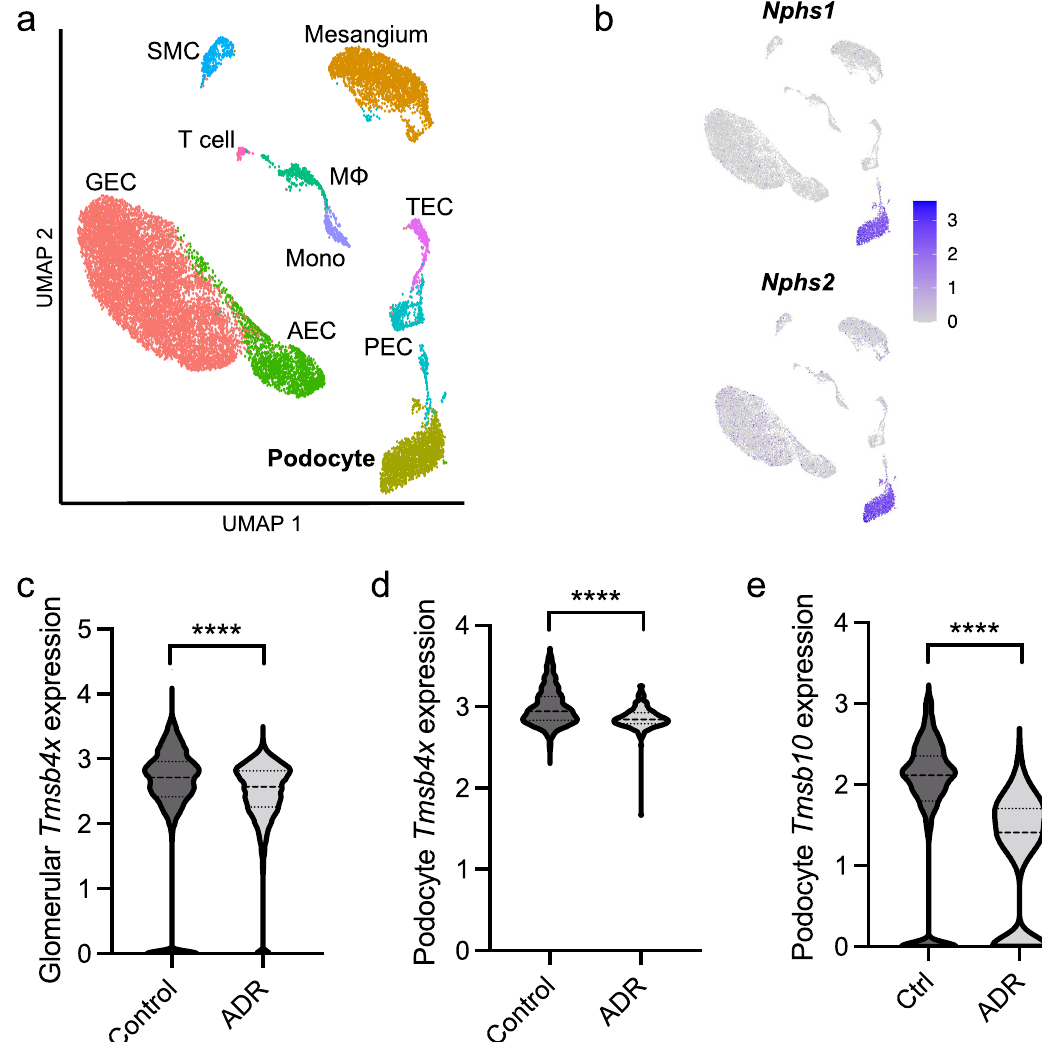
Figure 1. Podocyte-specific Tmsb4x and Tmsb10 expression is downregulated in murine Adriamycin nephropathy. (a) Uniform manifold approximation and projection (UMAP) from single-cell RNA sequencing data of 8412 glomerular cells from two wildtype (control) mice and 8296 glomerular cells from mice with Adriamycin nephropathy (ADR). After analysis and cell type assignment, ten transcriptionally distinct cell populations were discriminated including arterial endothelial cells (AEC), glomerular endothelial cells (GEC), macrophages (MΦ), mesangial cells, monocytes (Mono), parietal epithelial cells (PEC), podocytes, smooth muscle cells (SMC), T cells, tubular epithelial cells (TEC). The markers used for cell type identification and assignment, and the numbers of cell types per condition, are shown in Supplementary Fig. 1. (b) Feature plots showing expression of nephrin (Nphs1) and podocin ( Nphs2), canonical markers of podocytes, across the dataset. (c) Violin plot comparing the scaled expression of Tmsb4x of all glomerular cells (podocytes, GECs, mesangium) between ADR ( n = 5602 cells) and control ( n = 7190 cells). An average log fold decrease of 0.23 was detected in ADR compared to control (*: adjusted P value < 0.0001). (d) Violin plot comparing the scaled expression of Tmsb4x of podocytes between ADR ( n = 378 cells) and control ( n = 1486 cells). An average log fold decrease of 0.52 was detected in ADR compared to control (****: adjusted P value < 0.0001). (e) Violin plot comparing the scaled expression of Tmsb10 of podocytes between ADR and control. An average log fold decrease of 1.52 was detected in ADR compared to control (****: adjusted P value <